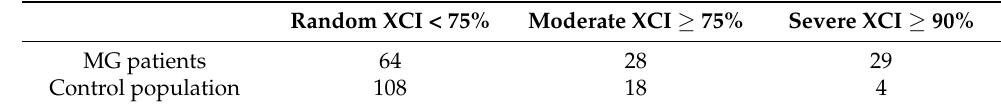
Table 2. Distribution of XCI pattern in case and control population.